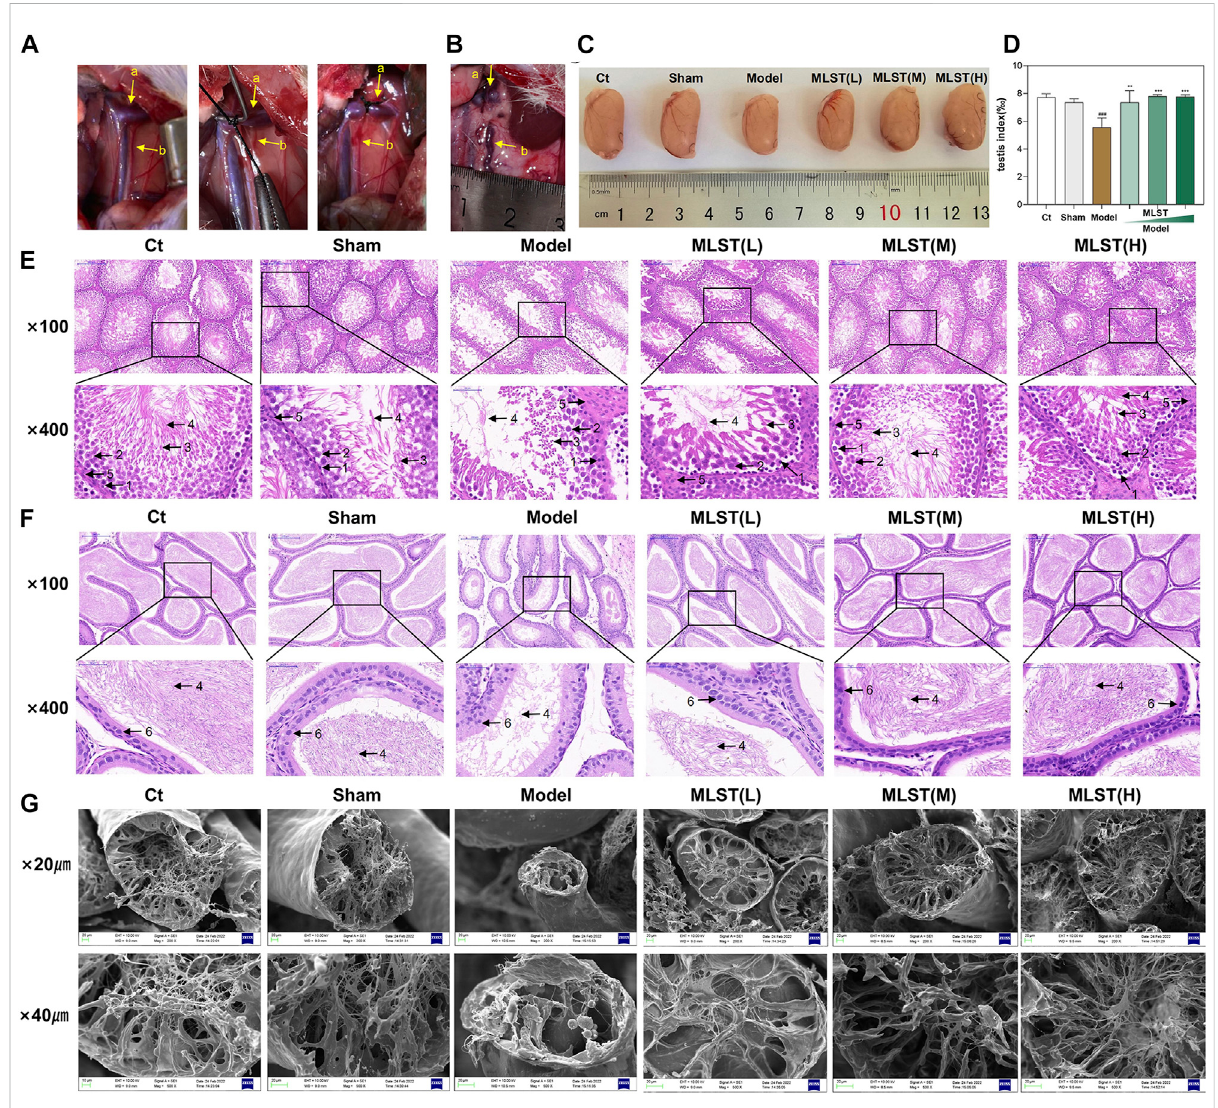
FIGURE 4 Preparation of VC rat model and histopathological changes of testicular tissue and epididymis. (A) The model of varicocele was made by narrowing the left renal vein and increasing the re fl ux pressure of the spermatic vein; a, left renal vein; b, spermatic vein. (B) The rat model of VC was successfully prepared byTurner ’ smethod, and obvious varicocele was seen. (C) Testisofdifferentgroups. (D) Changes intesticular massin different groups; N = 6; # p < 0.05, ## p < 0.01, ### p < 0.001 compared to Ct; * p < 0.05, ** p < 0.01, *** p < 0.001 compared to Model. (E) HE staining of testicular tissue; 1, spermatogonia; 2, spermatocyte; 3, spermatid; 4, sperm; 5, leydig cell; (original magni fi cation × 100, × 400). (F) HE staining of epididymal tissue; 4, sperm; 6, epithelial cell; (original magni fi cation × 100, × 400). (G) Structural changes in the seminiferous tubules (scale bar × 20 μ m, × 40